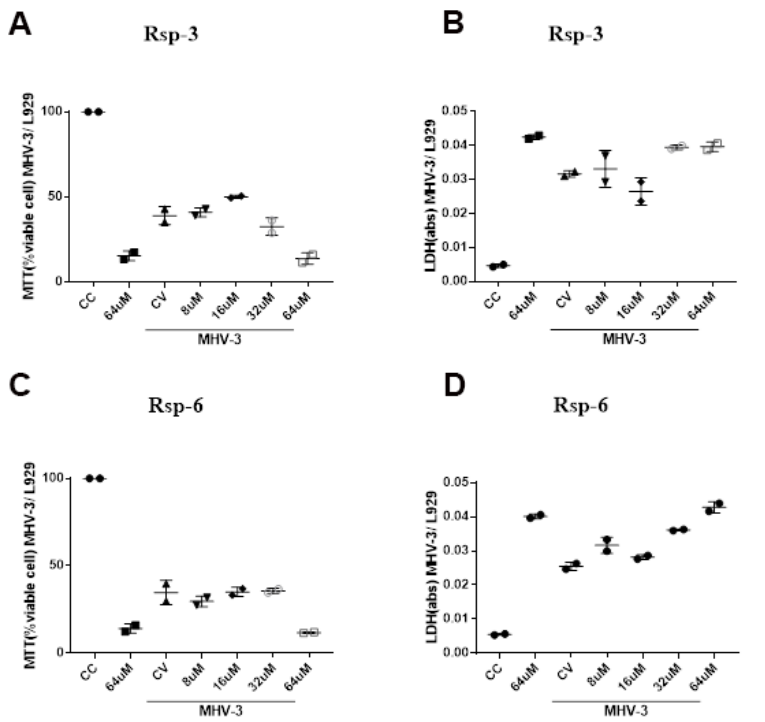
Figure 10. Biological effects of Raniseptins-3 and -6 on MHV-3-infected (L929) cells. Cell viability assessed by MTT assay (( A ), Rsp-3 and ( C ), Rsp-6) and by LDH assay (( B ), Rsp-3 and ( D ), Rsp-6).